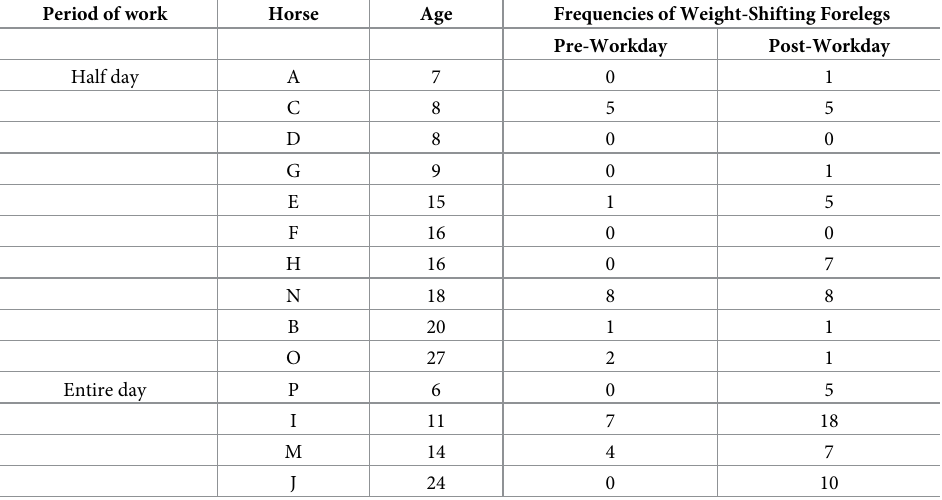
Table 7. Age of the 14 ranch horses and respective medians of the frequencies of weight-shifting forelegs assessed before and after a workday. Period of work